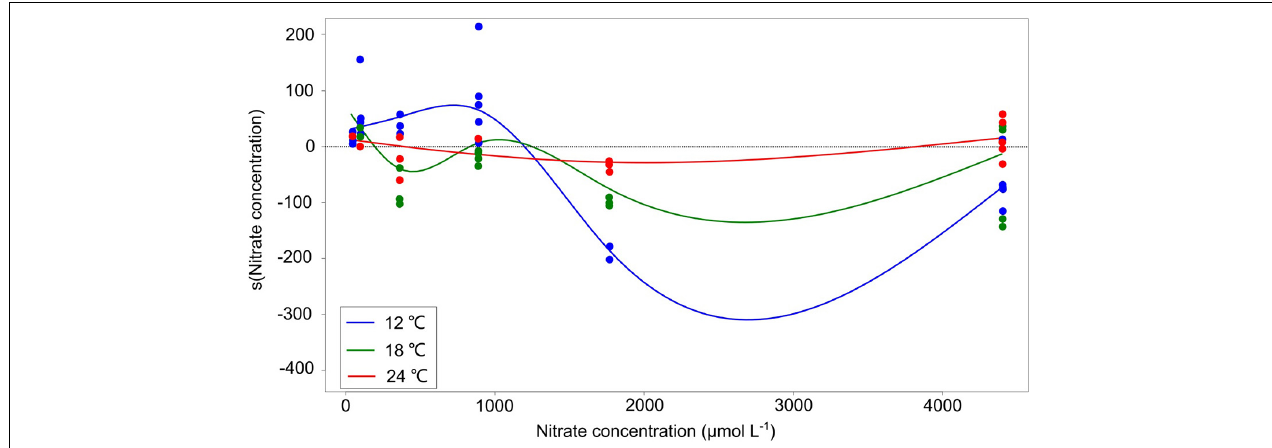
FIGURE 3 | Partial residuals of the non-linear estimation from the generalized additive models (GAMs) with smoothing splines. The y-axis indicates the partial additive effect of nitrate concentration on interaction coefficient α , and s () is the shorthand for fitting smoothing splines. The solid curves are the estimates of the smooth with GAMs, and the dots represent observed data points. The summary of GAM results is shown in Table 2